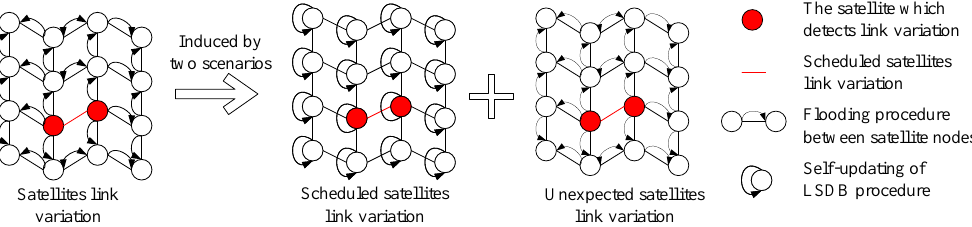
Figure 13. Flooding restraint and flooding procedure for the two scenarios of satellites link